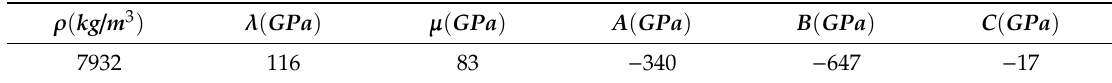
Table 1. Material properties of the plate.